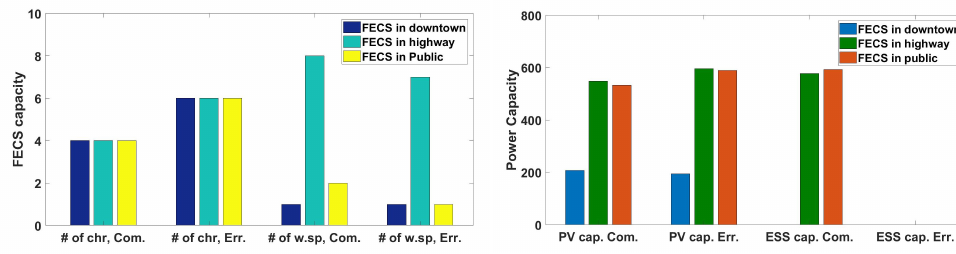
Figure 8. Optimal configuration of the FECS according to the locations for the commute (Com.) and errand (Err.) distribution.